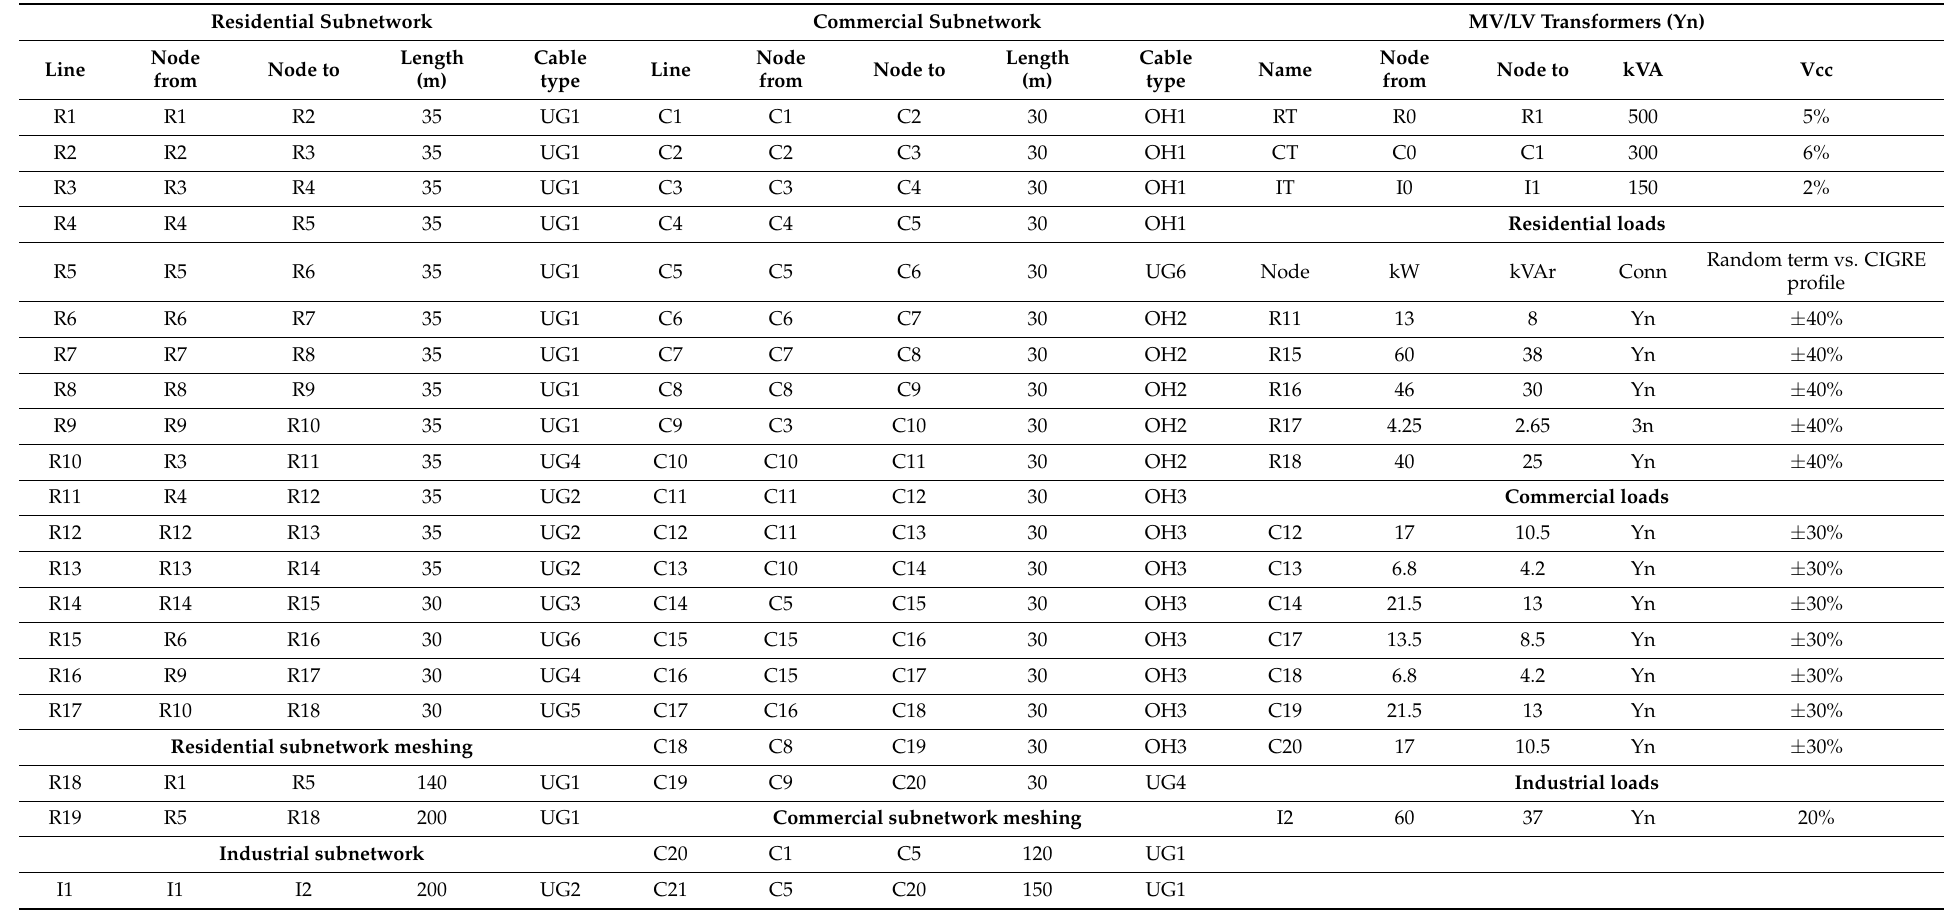
Table A2. Details about the connections among grid nodes, the characteristics of the loads tied to the grid, and the parameters of MV/LV transformers feeding the three sub-networks considered in the application example in Section